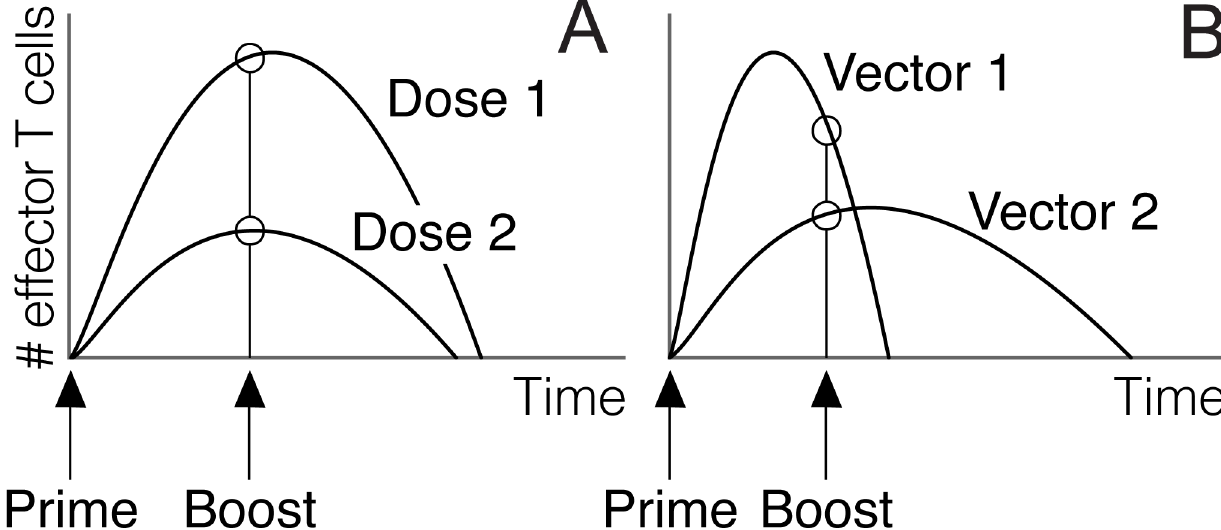
Fig 1. The effect of boosting at a fixed time after priming is expected to depend on T cell dynamics triggered by priming. A) Different antigen doses elicit T cell responses that can differ in their magnitude and duration [24, 31–36]. In this context, boost antigens inoculated at equal intervals after priming will interact with populations of effector T cells that differ in size. B) T cell populations primed with different vectors can be at different stages of the response (clonal expansion vs. clonal contraction) at a given time after the first injection.